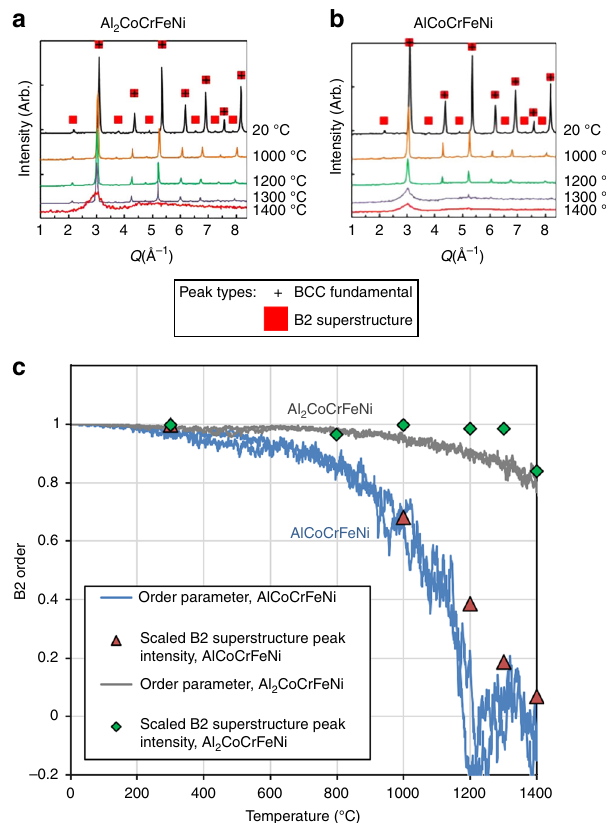
Fig. 4 Neutron diffraction patterns from in situ levitated heating studies, compared with simulations. a The plots of intensity versus scattering vector magnitude, Q , show that the Al 2 CoCrFeNi alloy produces one family of peaks corresponding to the BCC/B2 structure. The B2 superstructure peaks persist until the alloy melts near 1400 °C, indicating that the alloy never reaches the disordered state in the solid phase. b The AlCoCrFeNi alloy has a similar BCC/B2 structure. However, the superstructure signal becomes weak during heating, and is not observable at 1200 °C and above, indicating that the alloy may undergo an order-disorder transition. c A comparison of the B2 superstructure diffraction peak intensity for Q near 2.2 Å -1 , scaled by the value at 300 °C, with the B2-order parameter, η Al , from simulations. Note that the highest experimental temperatures shown here are close to the melting transformation. One general feature of all compositions is the peak shift due to